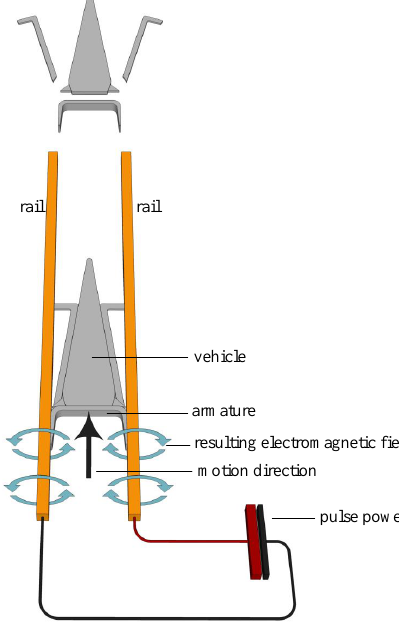
Figure 1. Basic principle of an electromagnetic